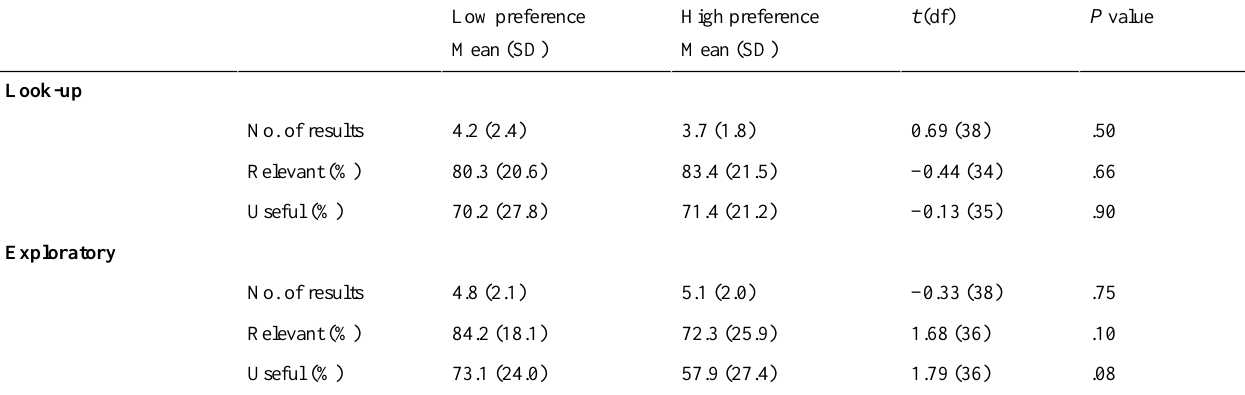
Table 6. Number of sites visited, the percentage of sites rated as relevant, and the percentage of sites rated as useful.